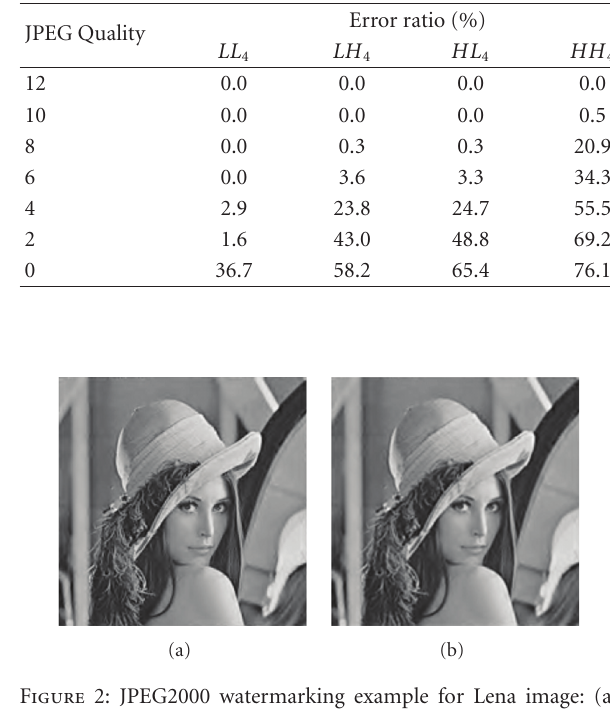
Table 1: Subband robustness in JPEG.